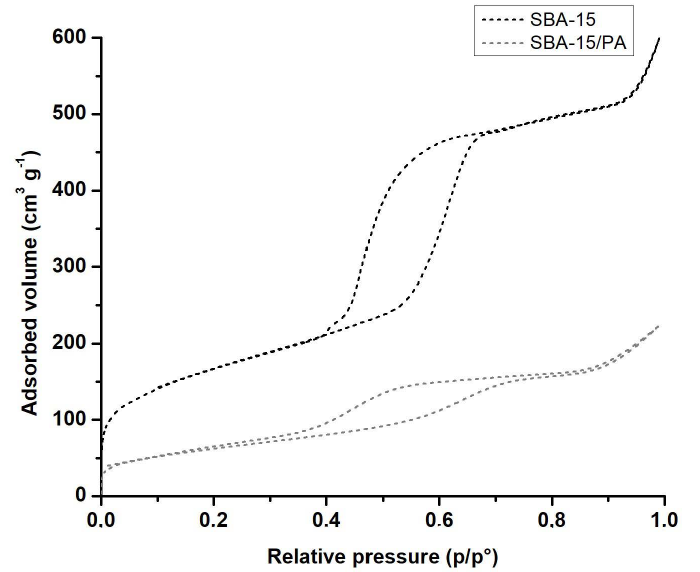
Figure 1. Nitrogen adsorption isotherms at 77 K for SBA-15 and